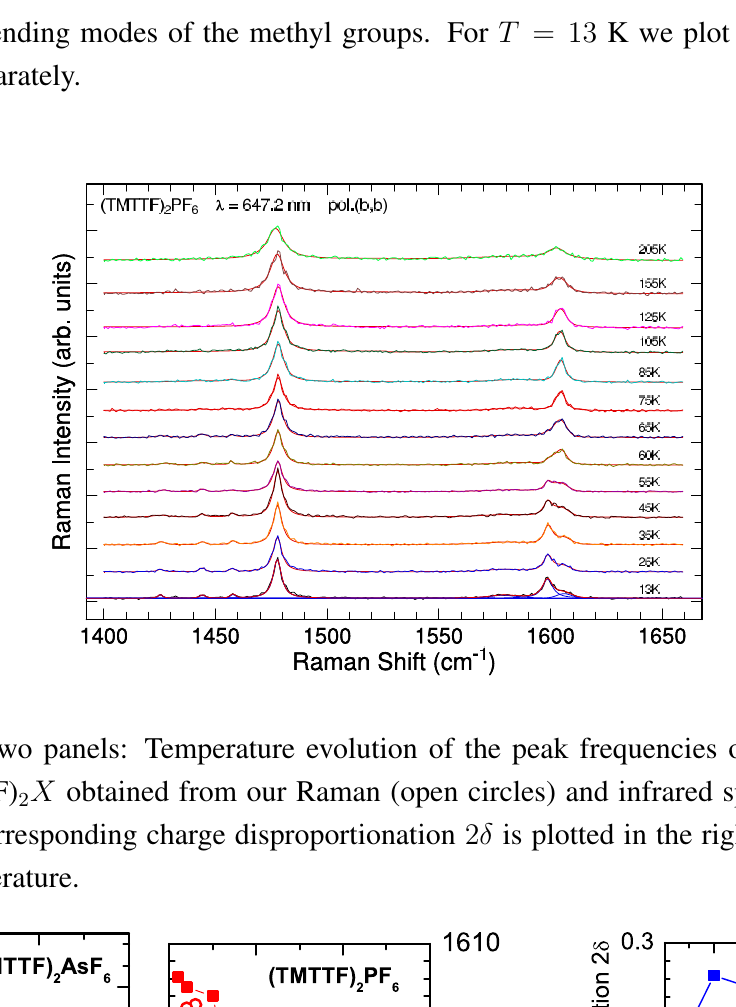
Figure 7. Raman spectra of (TMTTF) PF as a function of temperature. Similar to the 2 6 ( a ) mode around 1600 cm − 1 splits as the temperature spectra of (TMTTF) AsF , the ν 2 6 3 g = 67 K and three features evolve between 1425 and 1460 cm − 1 that can drops below T CO be assigned to bending modes of the methyl groups. For T = 13 K we plot the different contributions separately.